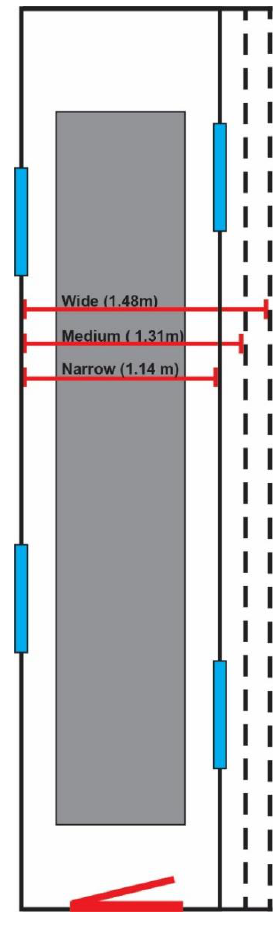
Figure 2. A top-down diagram of the research hallway and the three width conditions. The functional entrance is featured on the bottom of the diagram with the four distractor doors colored in